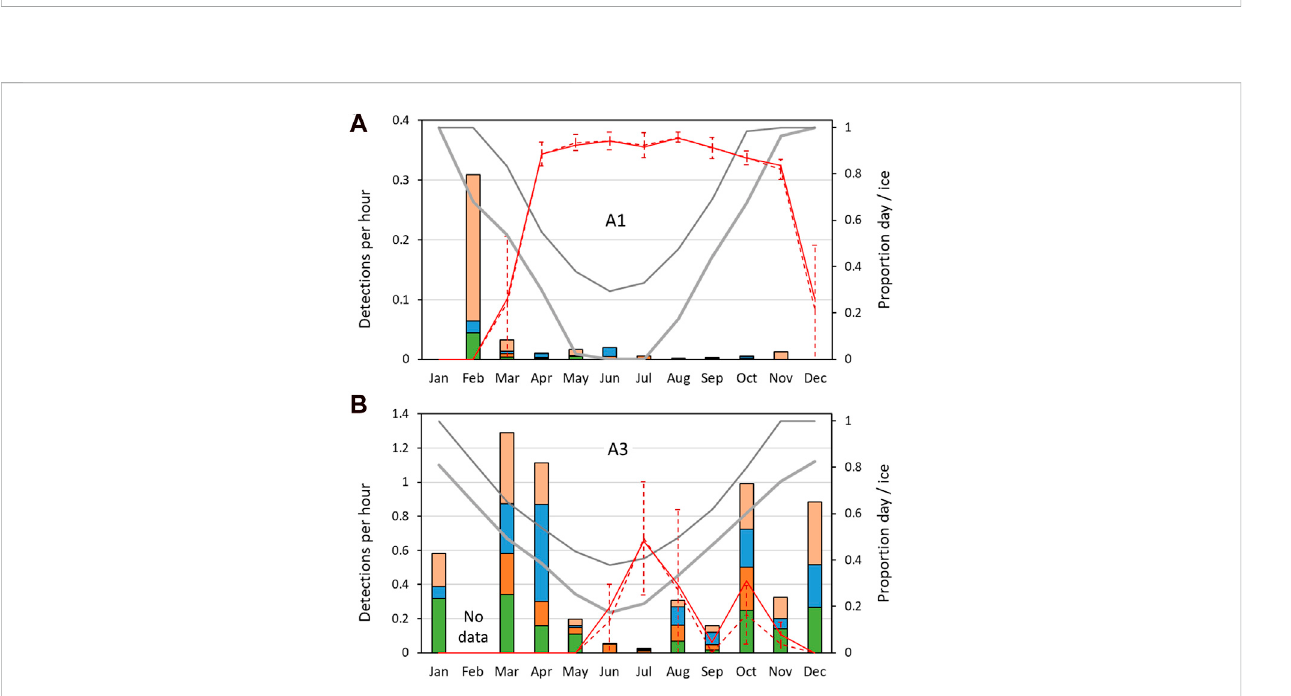
FIGURE 8 Meanspermwhaledetectionrate:meannumberofspermwhaleclick-trainsdetectedperhour,bymonth. (A) SouthernsiteA1; (B) northernsite,A3. Other information as Figure